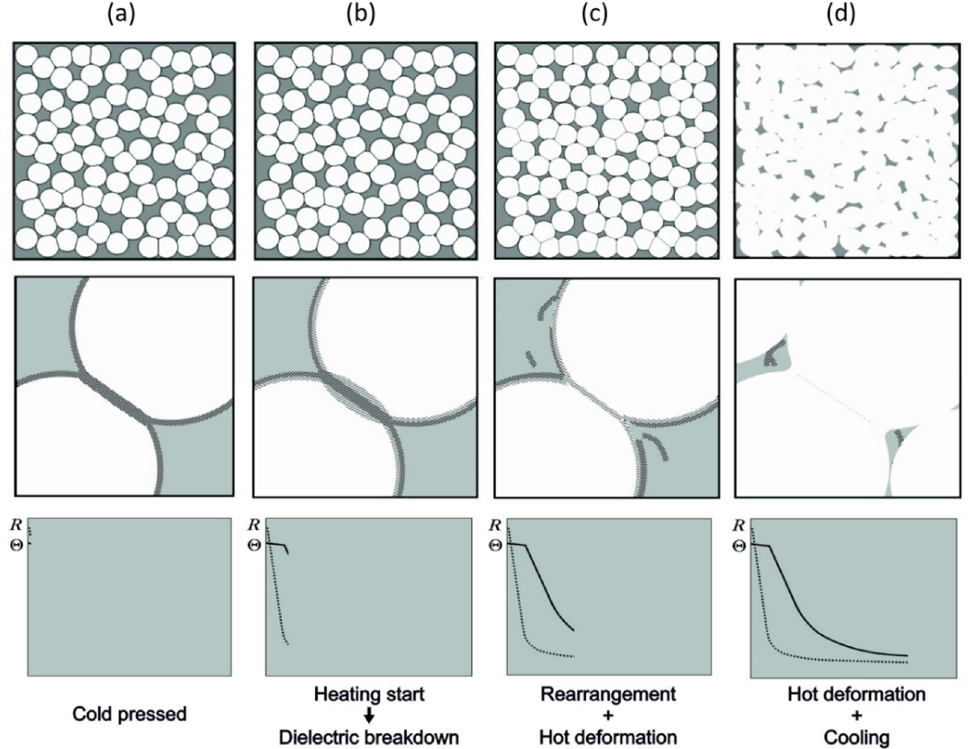
Figure 5. Microscopic interpretation of the different stages of the MF ‐ ERS process. ( a ) Initial status with oxidized powder particles under compression; ( b ) with heating, the oxide resistivity decays, although still not affecting the porosity; ( c ) after a sufficiently high temperature is reached in particle contacts, pressure provokes a particles rearrangement with mechanical descaling of the oxide layers, and a high densification takes place; ( d ) when rearrangement is no further possible, densification is due to particles hot deformation with a low variation of porosity and resistance.